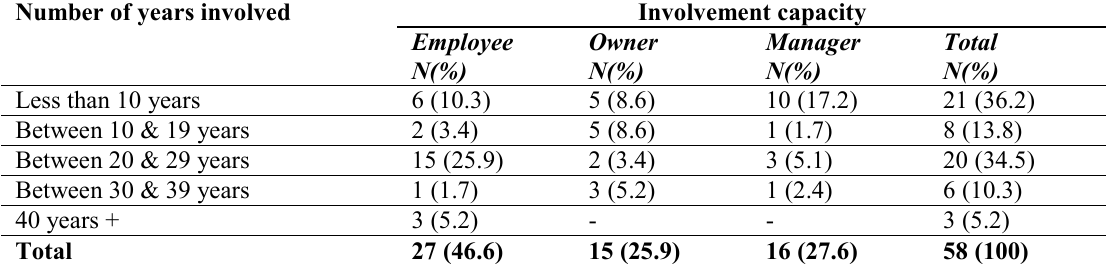
Involvement capacity Number of years